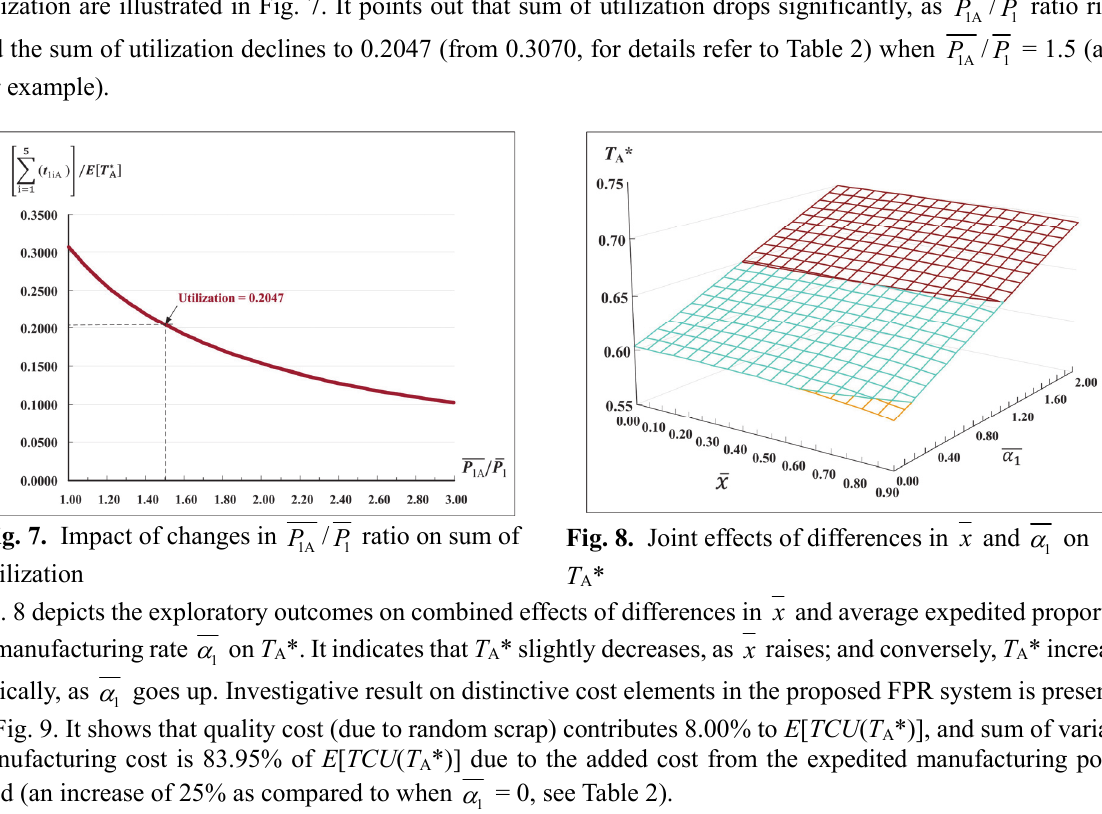
Fig. 8. Joint effects of differences in x and